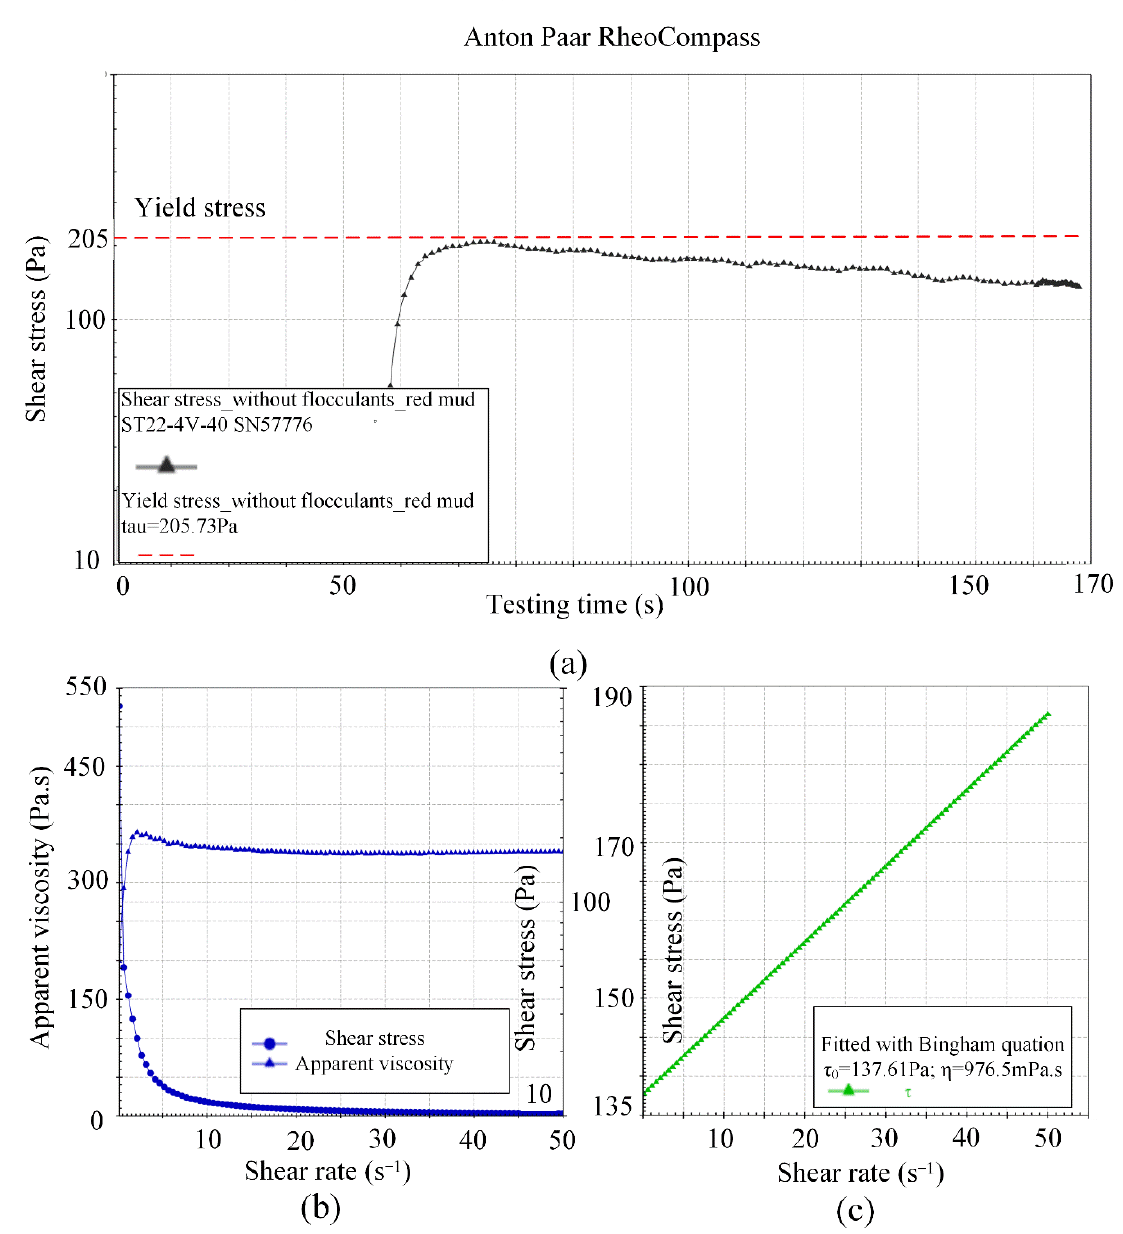
Figure 3. Flow curves of CPB under different shear conditions: ( a ) shear time vs. shear stress at constant shear rate; ( b ) shear rate vs. shear stress and apparent viscosity; ( c ) shear rate vs. shear stress fitted with Bingham equation.